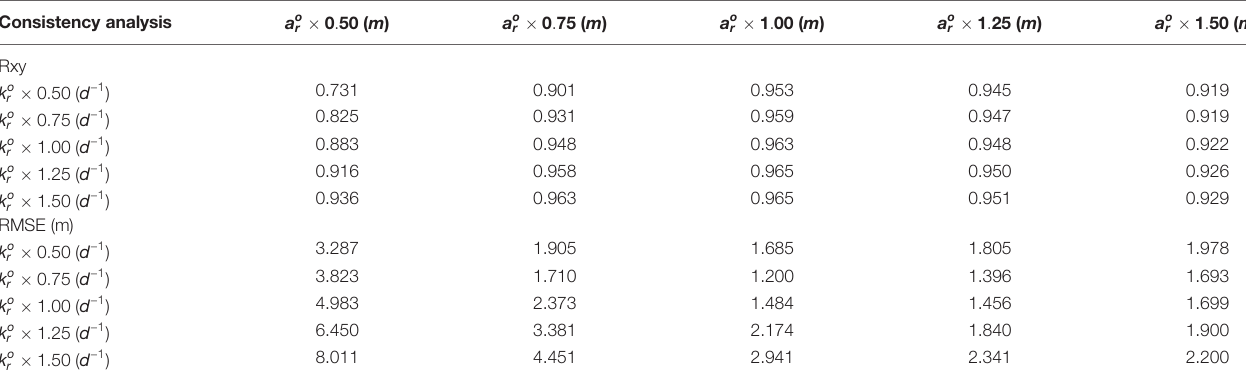
TABLE 6 | Results of consistency index based on the response factor and recovery factor of Maengbang Beach. Consistency analysis